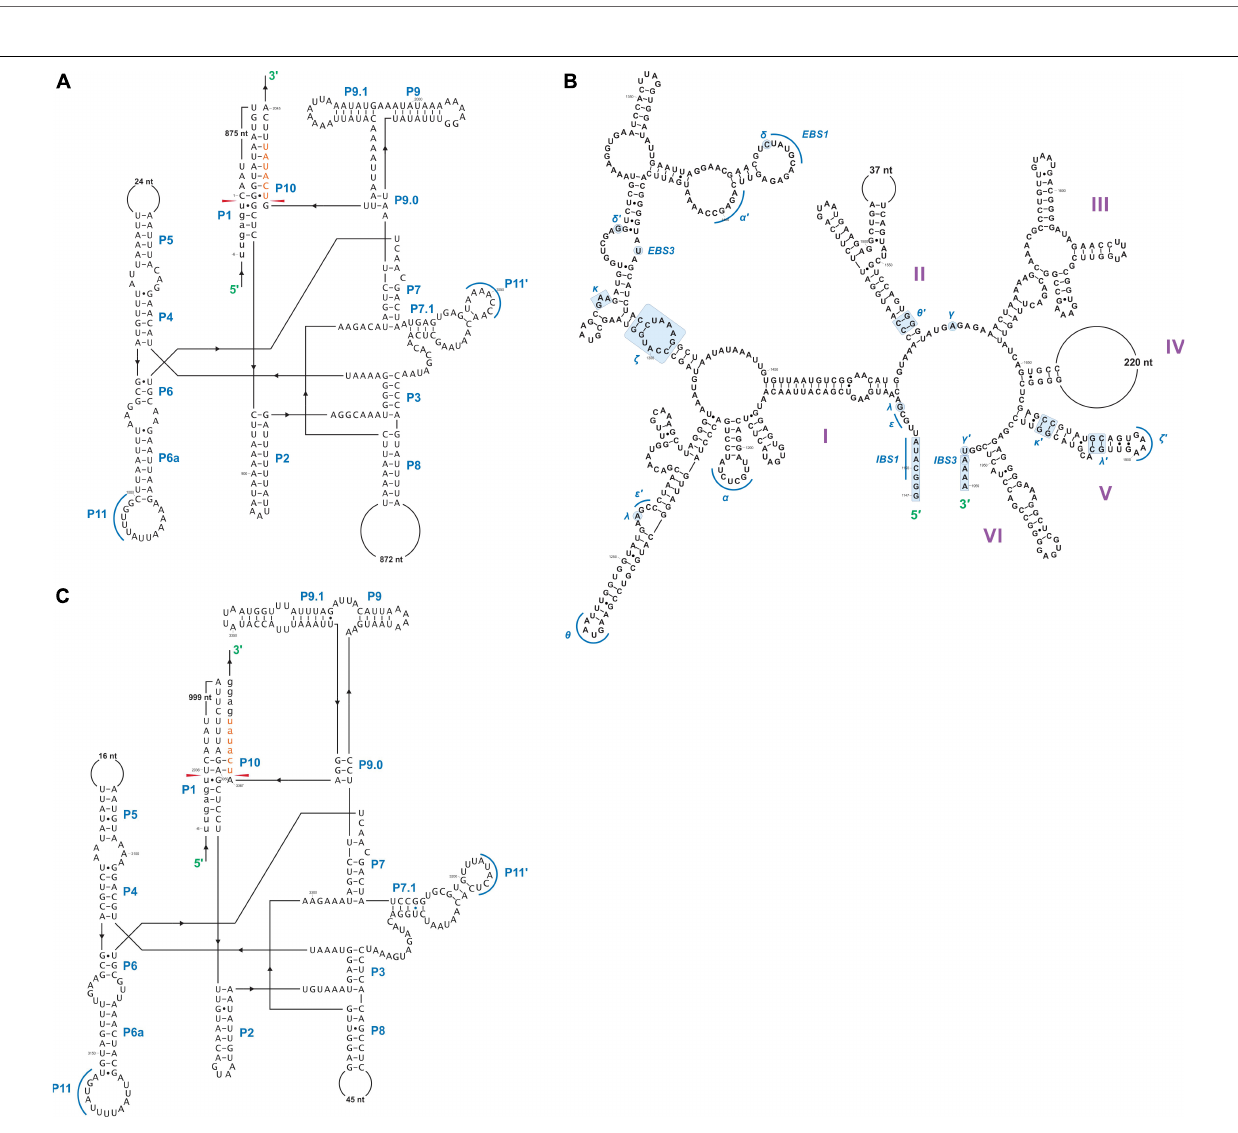
FIGURE 7 | Predicted cob I4 ( cob -490) RNA fold composed of three intron modules (A–C) . Pairing regions [for group I introns: P1–P11; and domains (D) I–VI for the group II intron] are labeled by purple text; tertiary interactions are shown by blue lines. Exon and intron sequences are represented by lowercase and uppercase letters, respectively. Red arrows indicate intron-exon/pseudoexon boundaries. Orange subsequence in uppercase letters is exon-mimicking (pseudoexon) sequence, which is annotated as within cob I4’s downstream group IA1 intron component ( cob I4-C). Orange subsequence in lowercase letters is annotated as downstream exon sequence ( cob -EB). (A) cob I4’s upstream group IA1 intron ( cob I4-A) RNA secondary structure model. (B) cob I4-B RNA secondary structure model. IBS, intron binding sequence; EBS, exon binding sequence. Helical domains I–VI branching from a central linker sequence (“six fingered hand”) shown. Potential tertiary interactions (Greek letters) are indicated. (C) cob I4’s downstream group IA1 intron (cob I4-C) RNA secondary structure